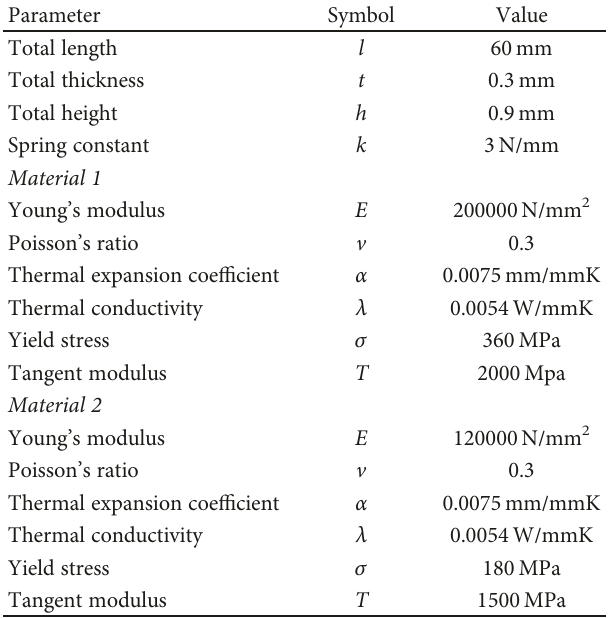
Table 3: List of parameters of the linear actuator